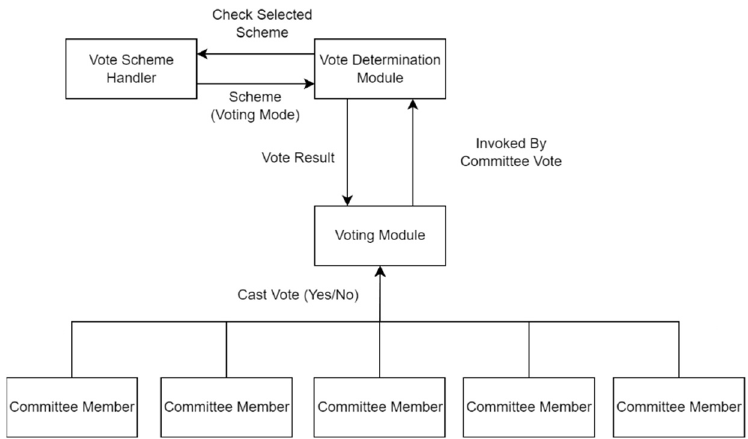
Figure 4. Voting module